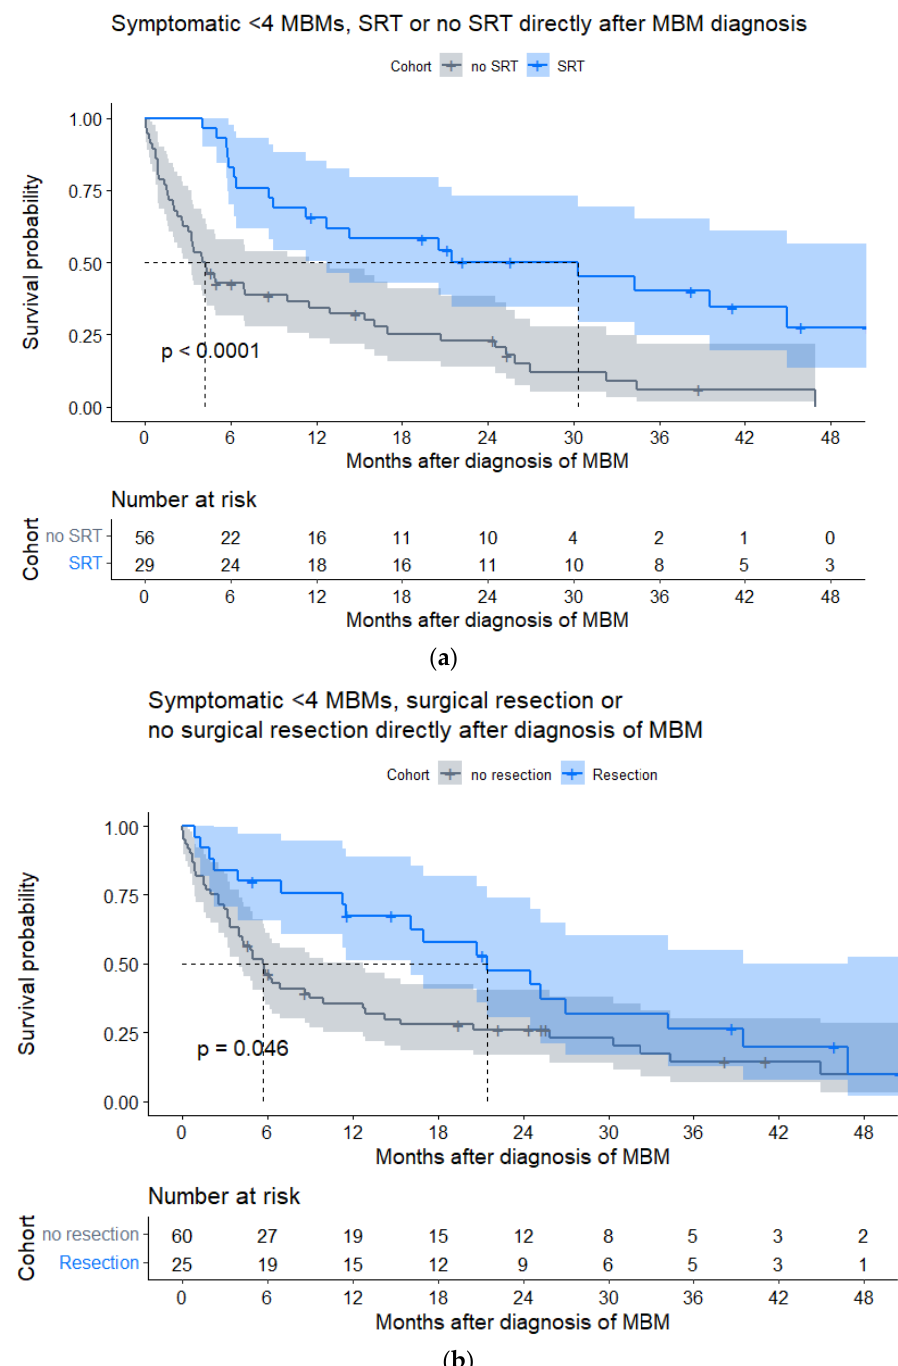
Figure A4. Kaplan – Meier curves in symptomatic patients with <4 melanoma brain metastases (MBMs) of the post-2015 cohort ( n = 85) and local treatments given directly after diagnosis of MBM. ( a ) Stereotactic radiotherapy (SRT) or no SRT directly after MBM diagnosis. ( b ) Surgical resection or no surgical resection directly after MBM diagnosis.